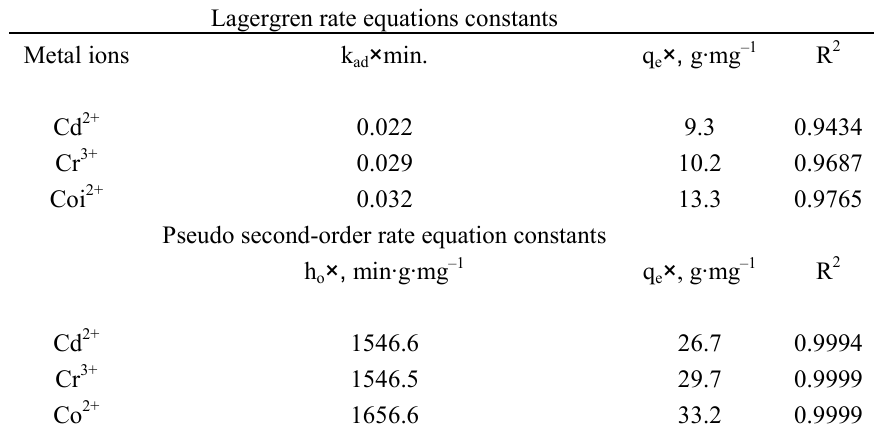
Table 2 . Lagergren rate equation constants and pseudo second-order rate equation constants for Cr 3+ , Cd 2+ , and Co 2+ adsorption on